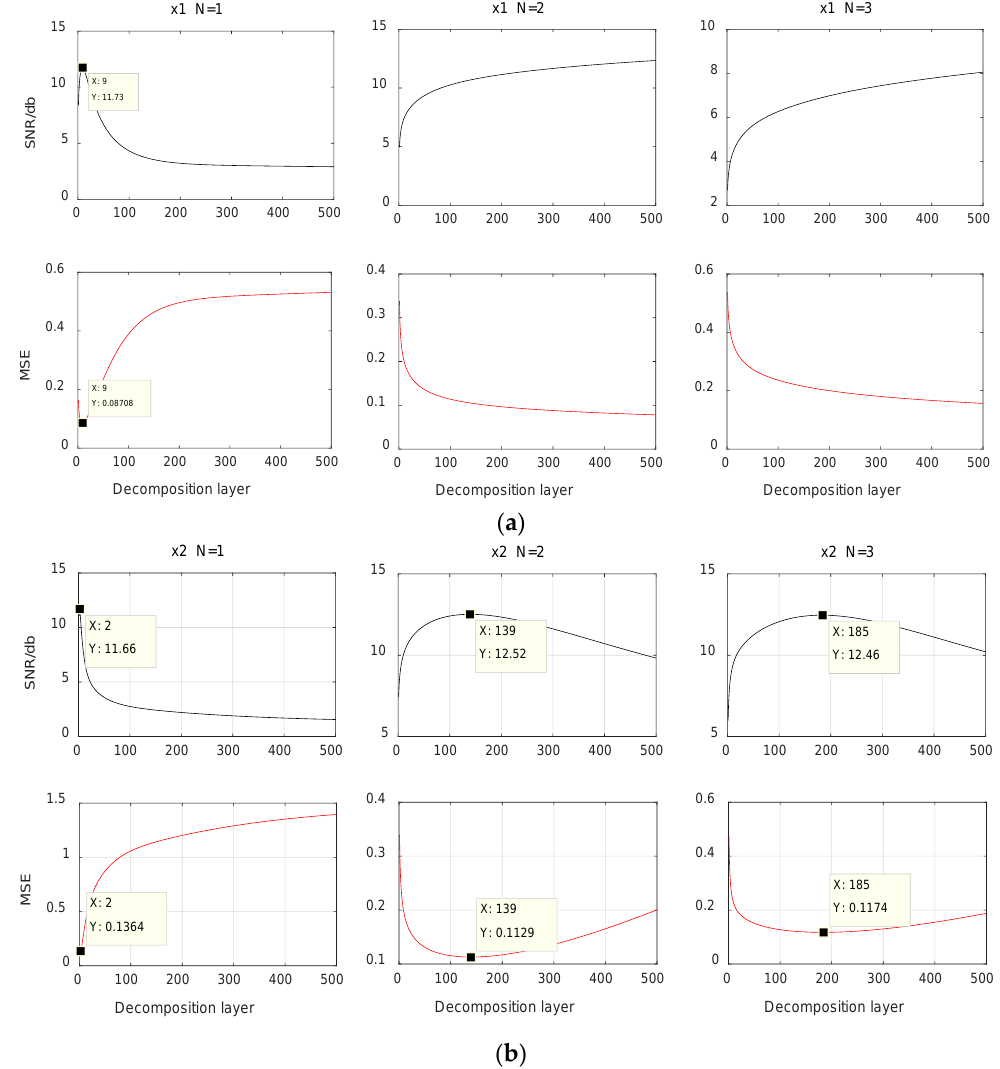
Figure 5. The SNR and MSE in the four-division method. ( a ) x1, ( b ) x2.